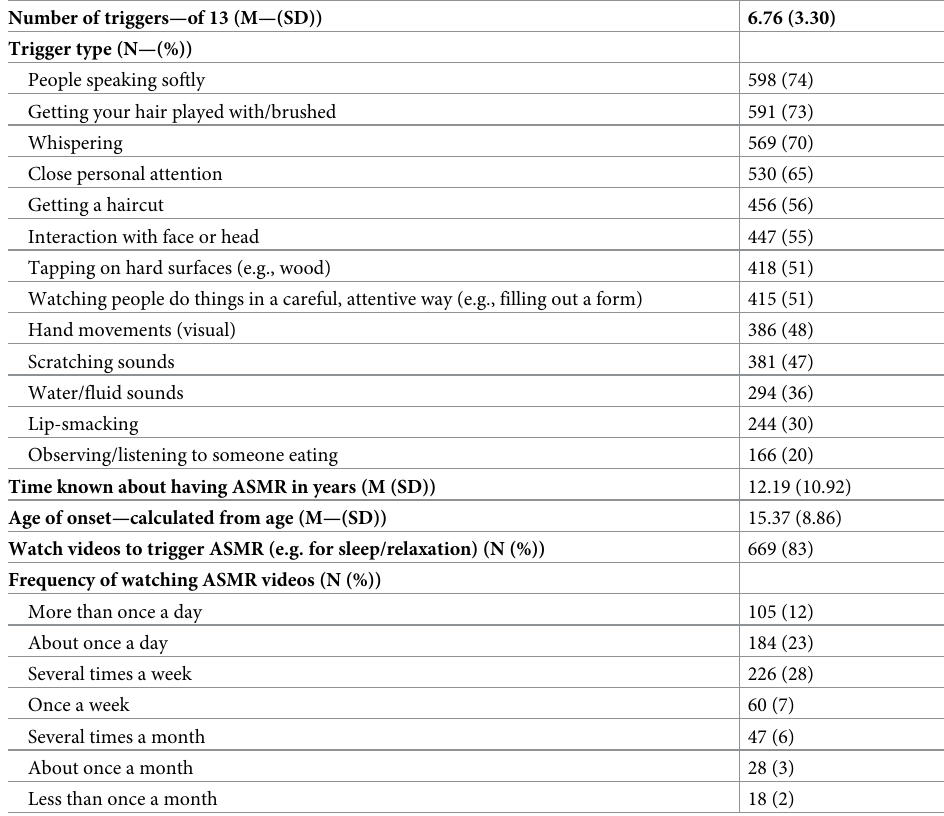
Table 1. Common triggers, age of onset and ASMR video use in ASMR participants (N = 813). Number of triggers—of 13